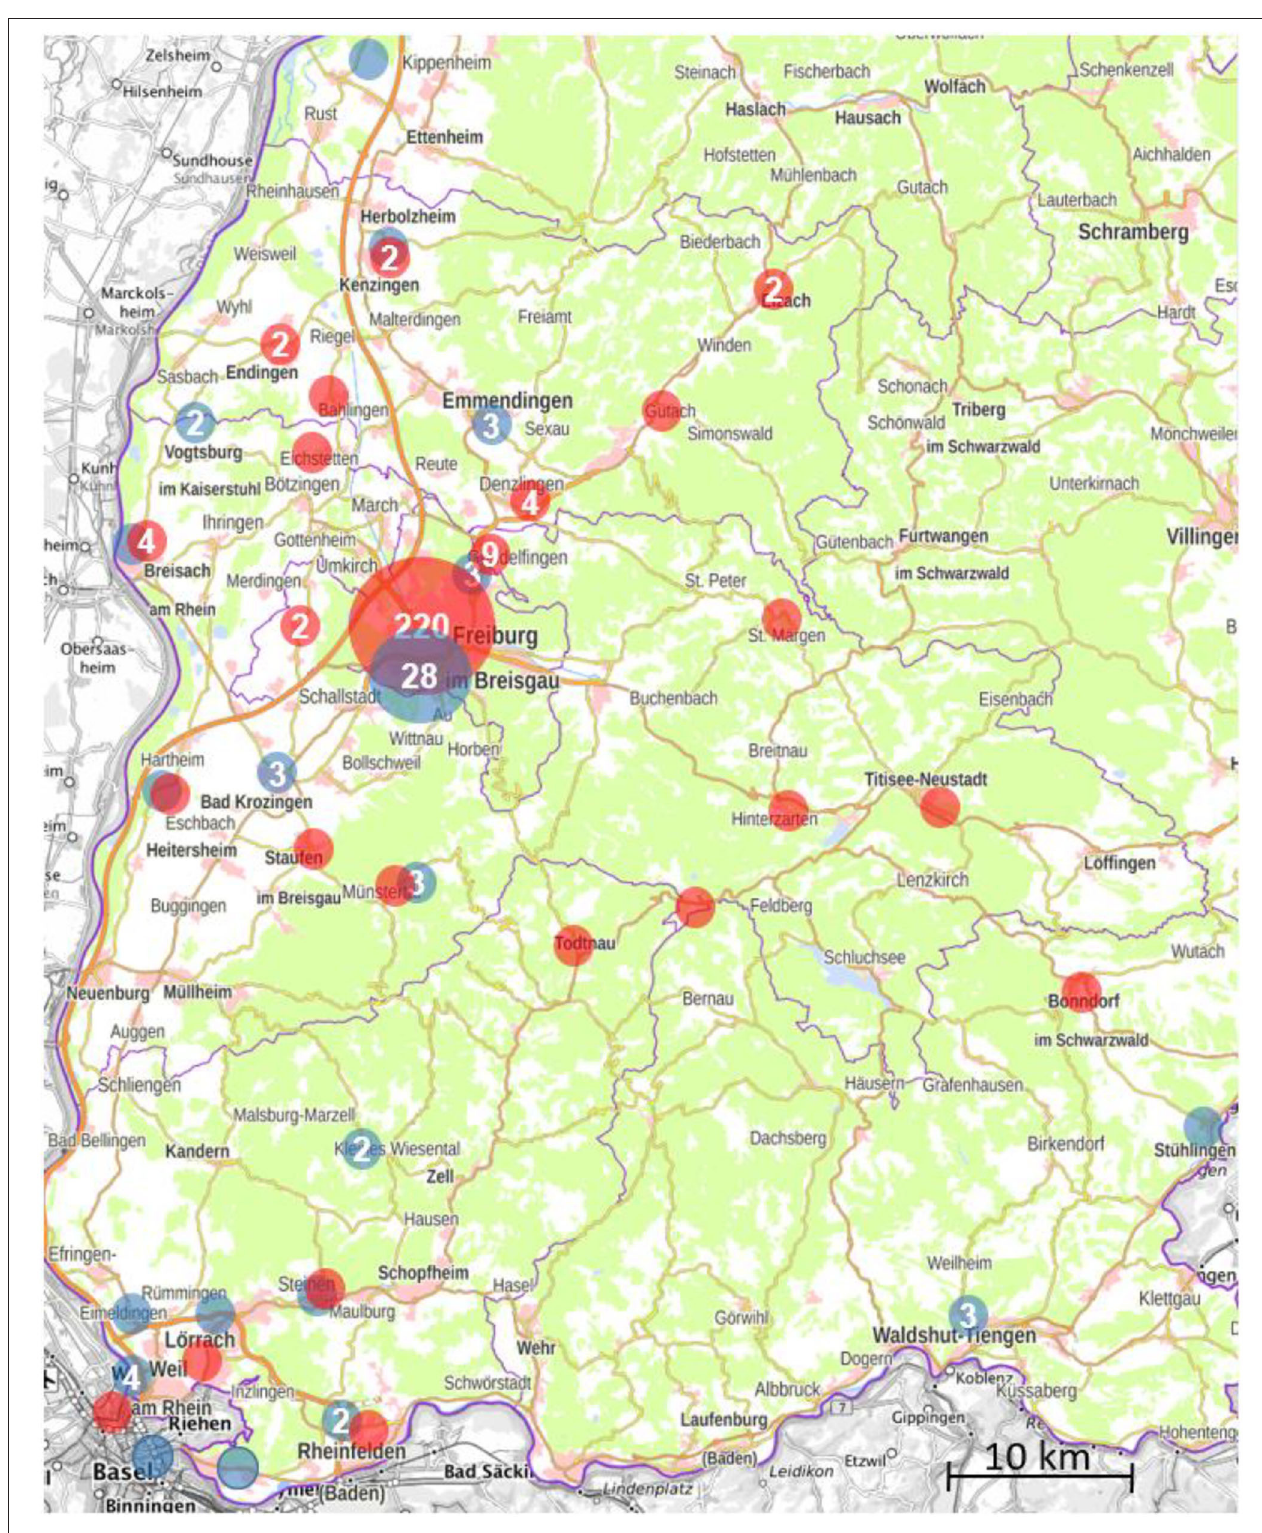
FIGURE 1 | Places of residence of clients according to postcode presenting at the Center for Sexual Health Freiburg, Germany, between 1 May 2020 and 28 February 2021. Red dots correspondent to clients presenting for sexual transmitted infection (STI)/HIV counseling, blue dots to pre-exposure prophylaxis (PrEP) users.